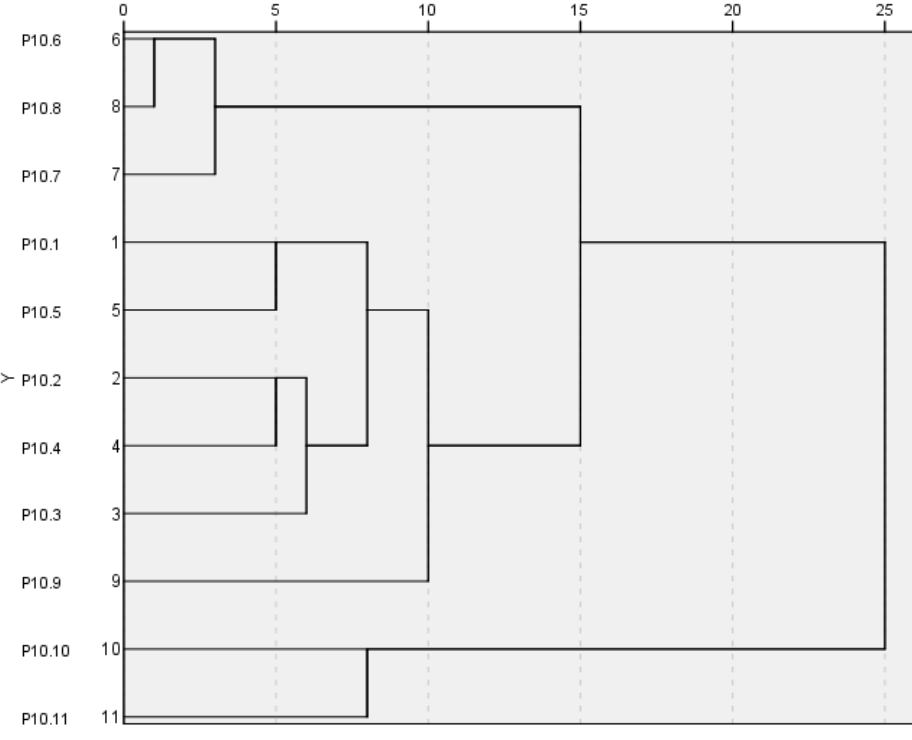
Figure 1. Dendrogram using the Ward link showing the structure of needs, which according to respondents, are satisfied due to cooperation with offerors. Where: symbols as in Table 1. Table 4. Respondents’ previous participation in cooperation with offerors, respondents’ openness to such cooperation, and the assessment of contemporary final purchasers’ readiness for cooperation